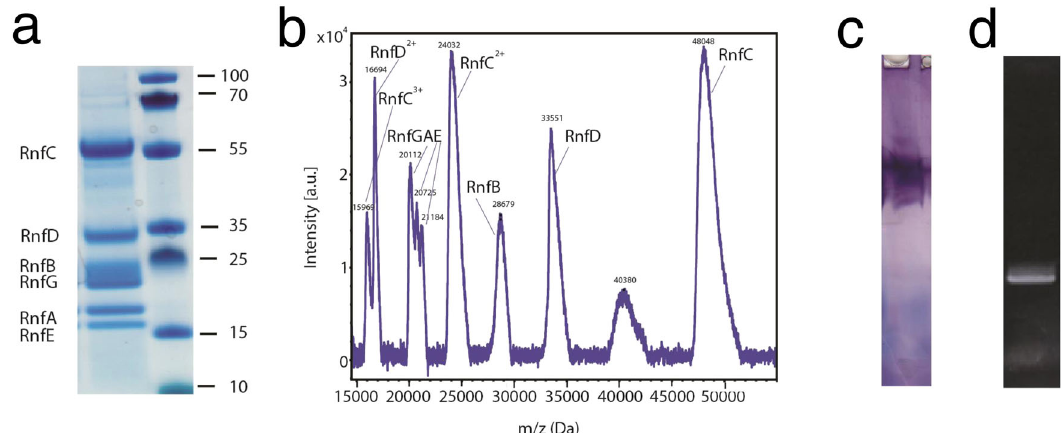
Fig. 1 | Biochemical analysis of the Rnf complex. a SDS-PAGE. The individual bands could be assigned as subunits RnfE, RnfA, RnfG, RnfB, RnfD, and RnfC. Molecular mass markers are given in kDa. The experiment was done twelve times. b Massspectrometry. Subunitidenti fi cationwasperformedbyMALDIMS analysis. MassspectrawererecordedwithRnf(2mg/ml)inbufferAbyusingaMALDI – time- of- fl ight (TOF)/TOF mass spectrometer. c Clear native PAGE (performed thrice).